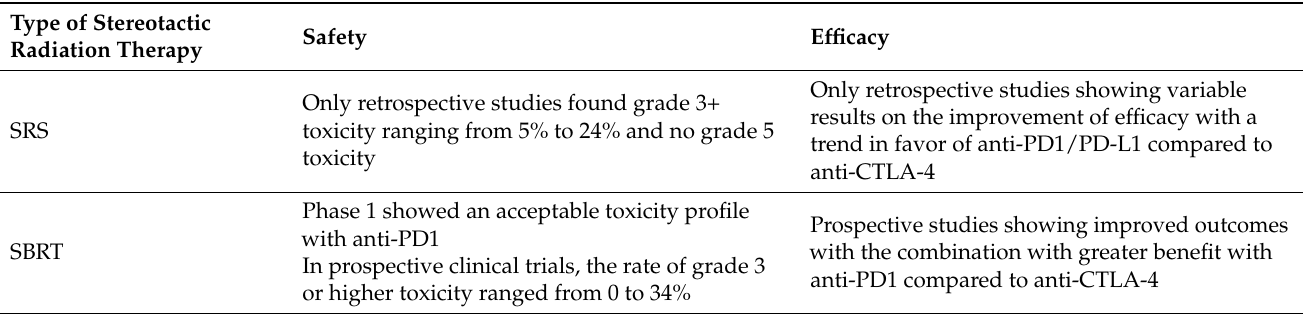
Only retrospective studies showing variable results on the improvement of efficacy with a trend in favor of anti-PD1/PD-L1 compared to anti-CTLA-4 Prospective studies showing improved outcomes anti-PD1 compared to